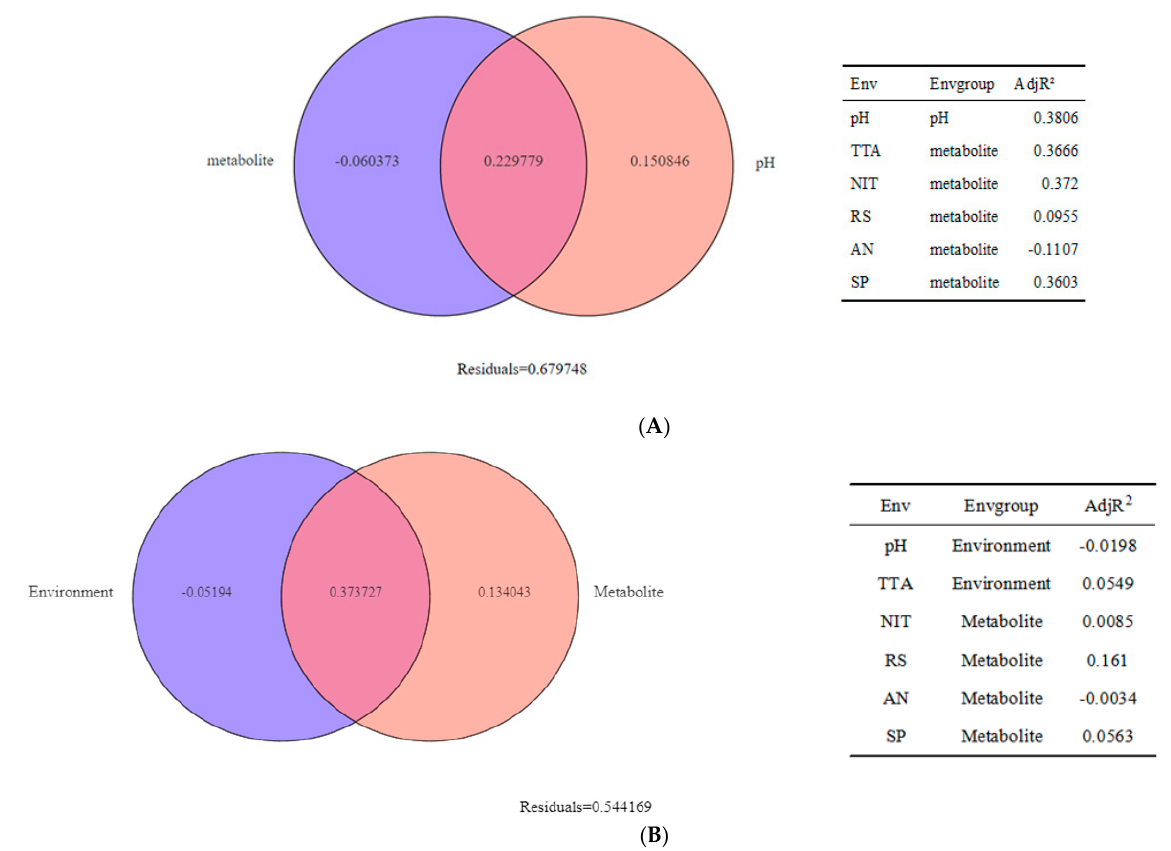
Figure 5. Variance partitioning analysis of environmental factors and metabolites explaining bacterial ( A ) and fungal ( B ) community diversity distribution pattern during paocai fermentation.